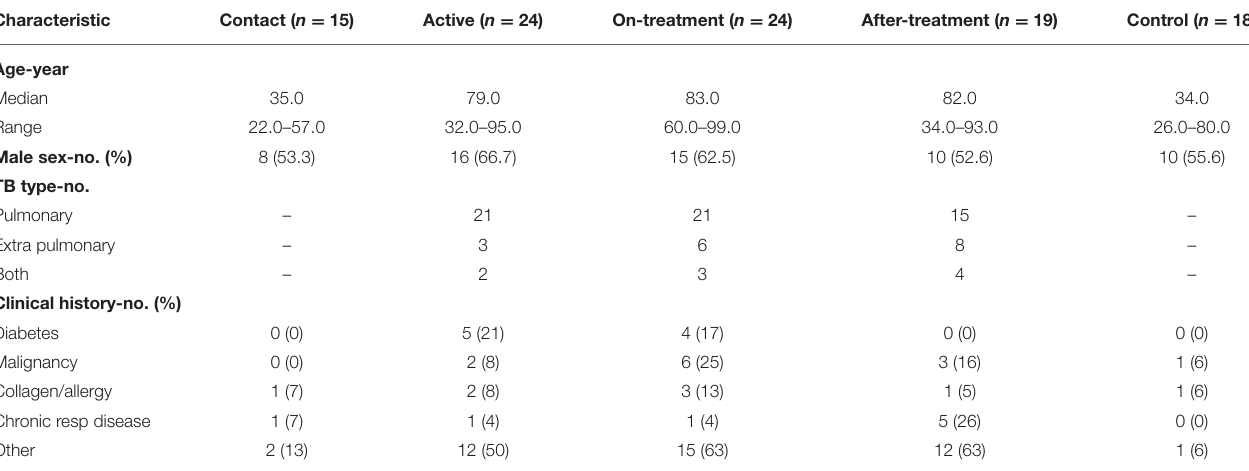
TABLE 1 | Characteristics of the